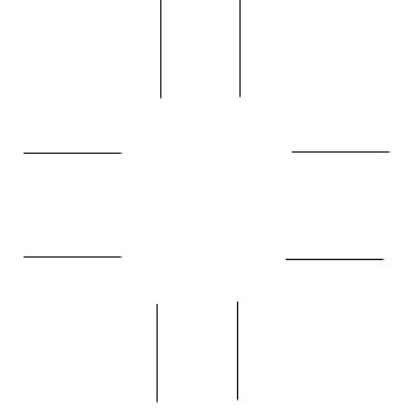
Figure 5 - Crossroads as four roads DOI: